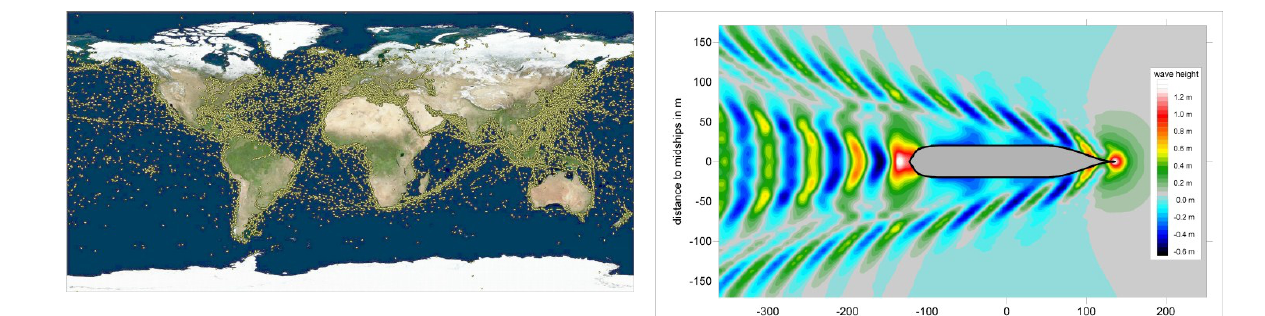
Figure 1. Vessel position reports received from NORAIS during 24 hours, 29 th June 2010, source FII, ESA.